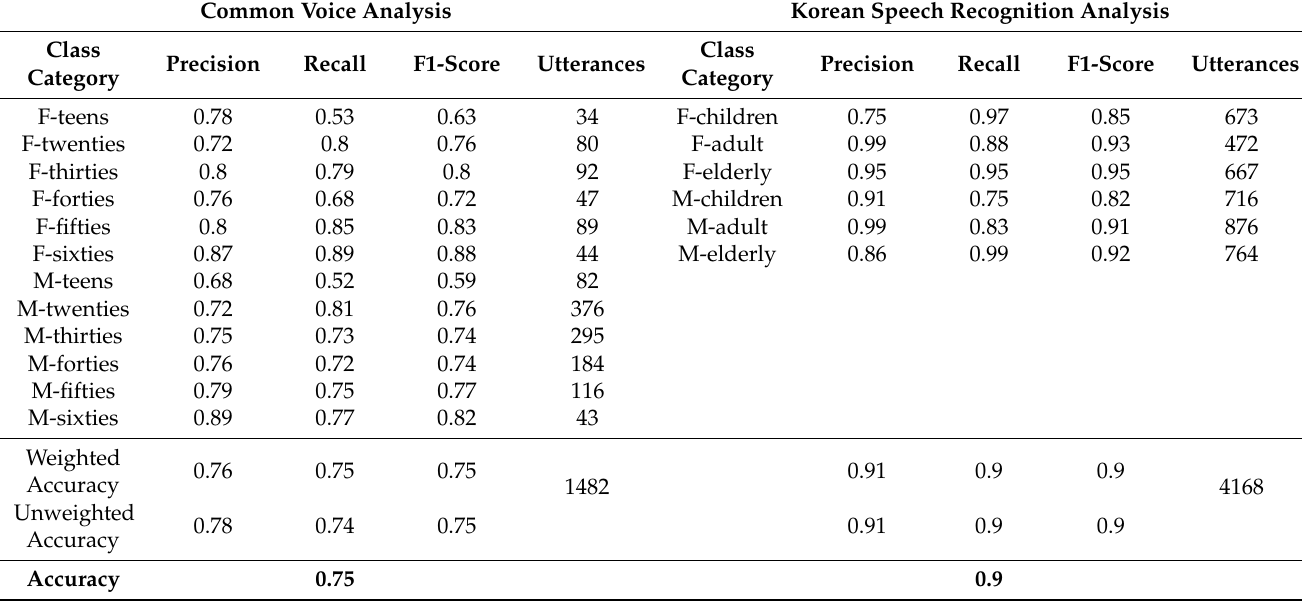
Table 6. A classification report of the proposed age and gender classification model on each dataset is provided to demonstrate precision, recall, F1-score, and weighted and unweighted accuracy results. F and M denote the female and male genders, respectively. Numbers with bold fonts indicate the average classification